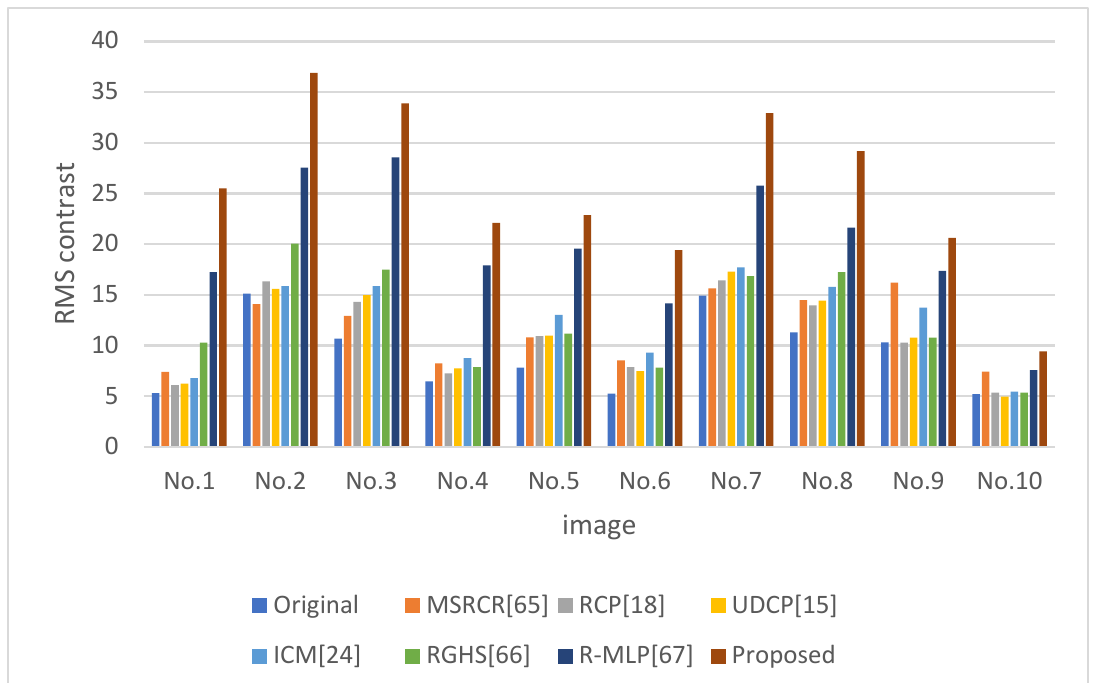
Figure 10. Comparison of RMS contrast [15,18,24,65–67].